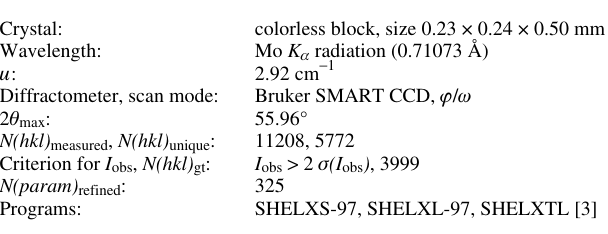
Table 1. Data collection and handling.